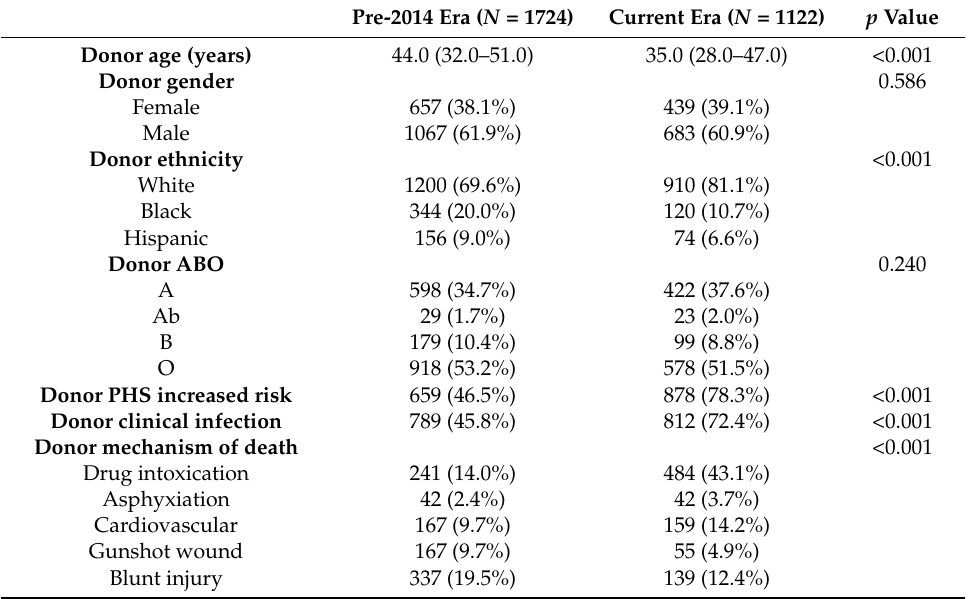
Table 4. Liver demographics and clinical characteristics from HCV seropositive donors by